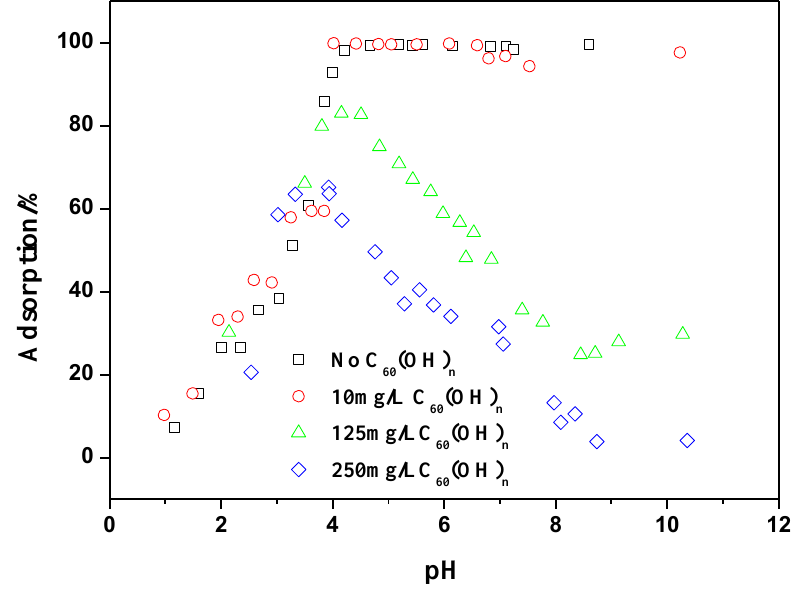
(OH) on Th(IV) adsorption onto oMWCNTs as a function of 60 n